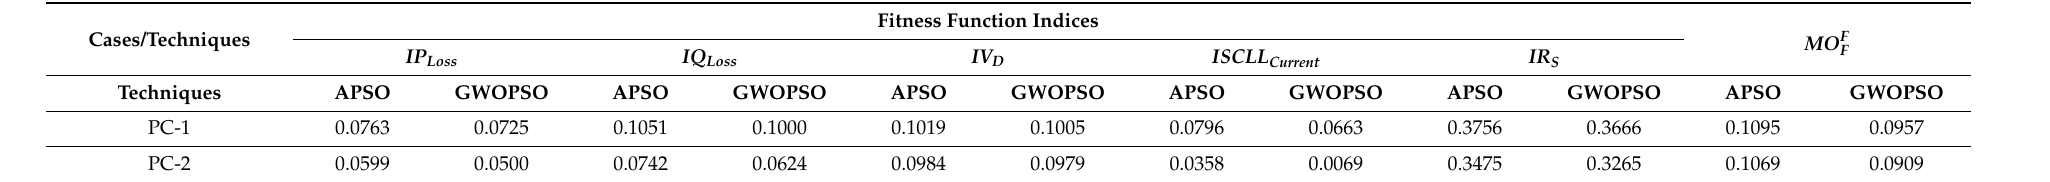
Table 5. The MO F and its indices for IEEE 33 bus RDN. F